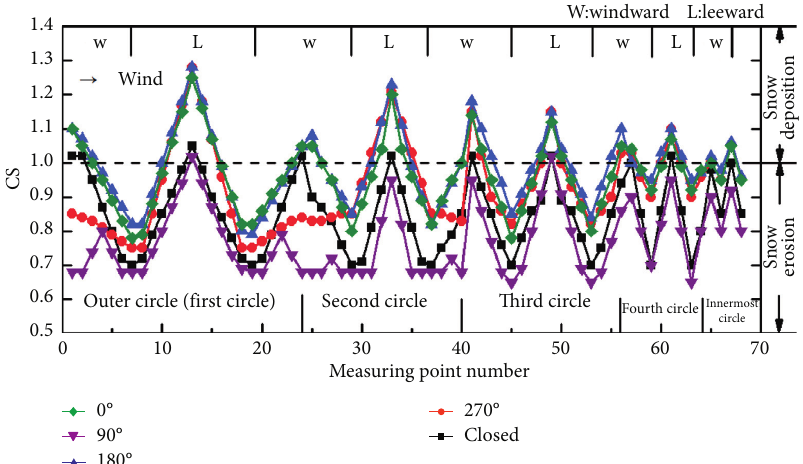
Figure 11: Snow distribution on the gymnasium surface for different opening directions.